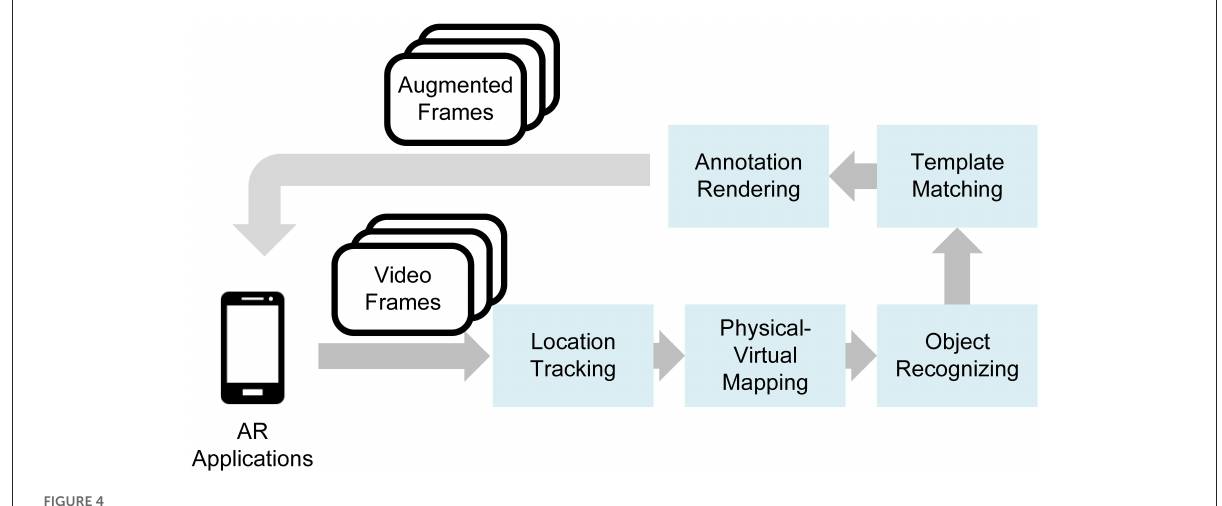
FIGURE4 Content processing and rendering for AR